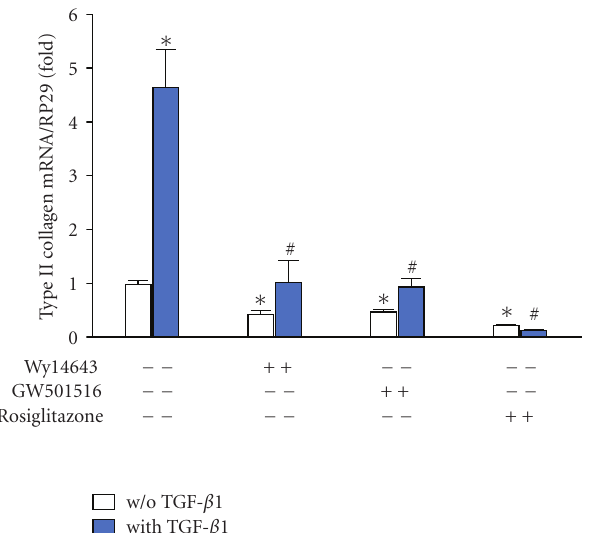
Figure 3: E ff ects of selective PPAR agonists on TGF- β 1-induced type II collagen mRNA expression in rat chondrocytes . Chon- drocytes, embedded in alginate beads (5.10 4 cells per bead), were exposed to Wy14643 (100 μ M), GW501516 (100 nM), or rosiglitazone (10 μ M) for 2h before stimulation with TGF- β 1 (10ng/mL), in the presence or absence of PPAR agonists for 48h. Normalized mRNA levels of type II collagen were quantified by real-time PCR ( n = 4). Data were expressed as mean ± SEM and statistically significant di ff erences from the control were indicated as ∗ P < . 05 and from TGF- β 1-treated cells as # P < . 05.